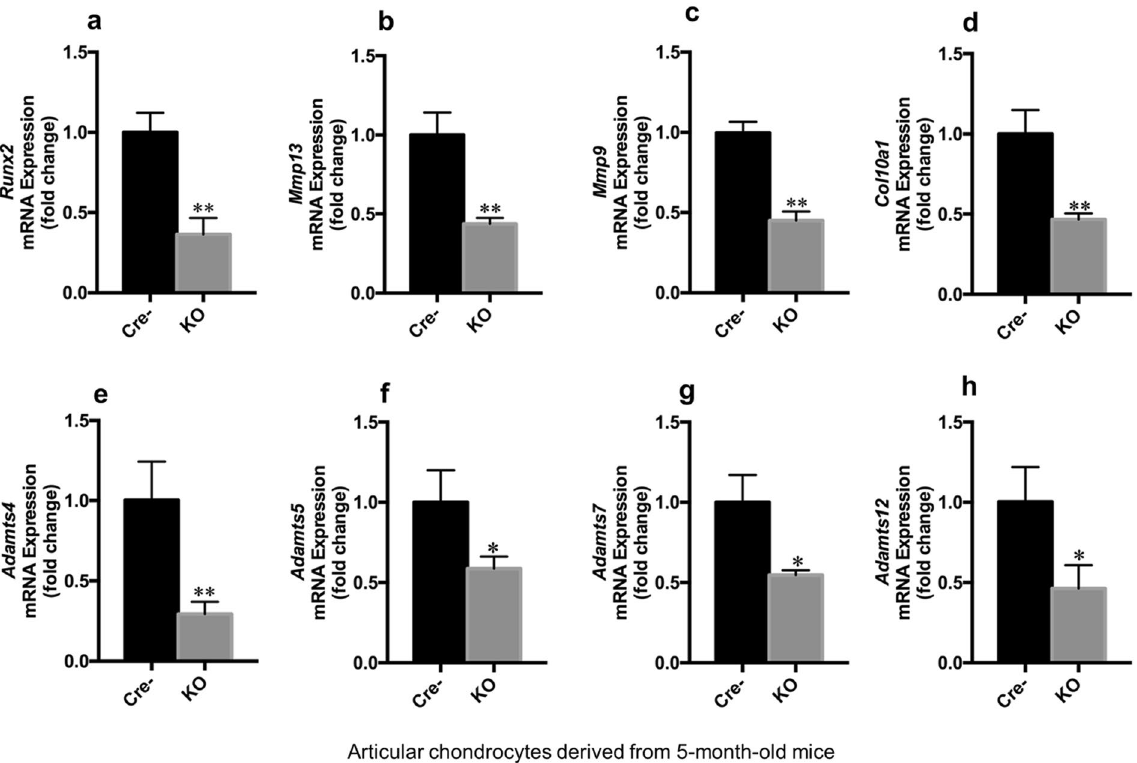
Figure 7. Loss of Runx2 in adult articular chondrocytes leads to decreased expression of genes encoding to matrix degradation enzymes. ( a – h ) Total RNA was extracted from articular chondrocytes isolated from 5-month-old Runx2 Agc1CreER KO mice (KO) or Cre-negative control mice (Cre − ) followed by real-time PCR assay. All these mice were administrated with tamoxifen at the two-months of age and received DMM surgery at 12-week-old. Expression of Mmp9 , Mmp13 , Adamts4 , Adamts5 , Adamts7 and Adamts12 was significantly reduced in articular chondrocytes derived from Runx2 Agc1CreER KO mice ( * P < 0.05 and ** P < 0.01, unpaired Student’s t -test; n = 3 mice per